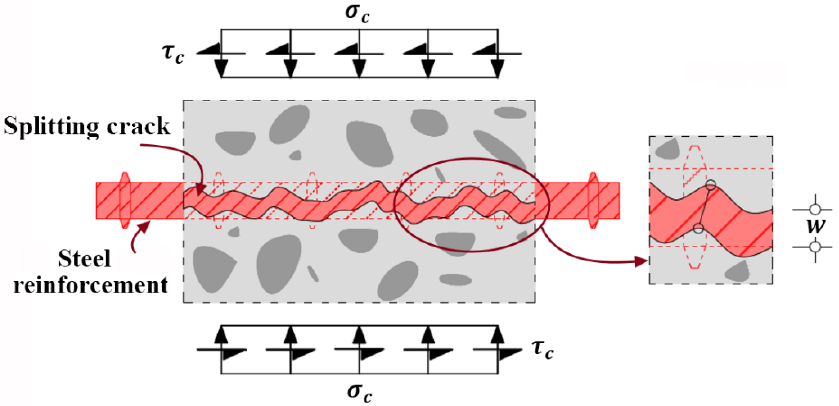
Figure 9. Calculation of dowel action of steel reinforcement [49,54–56].